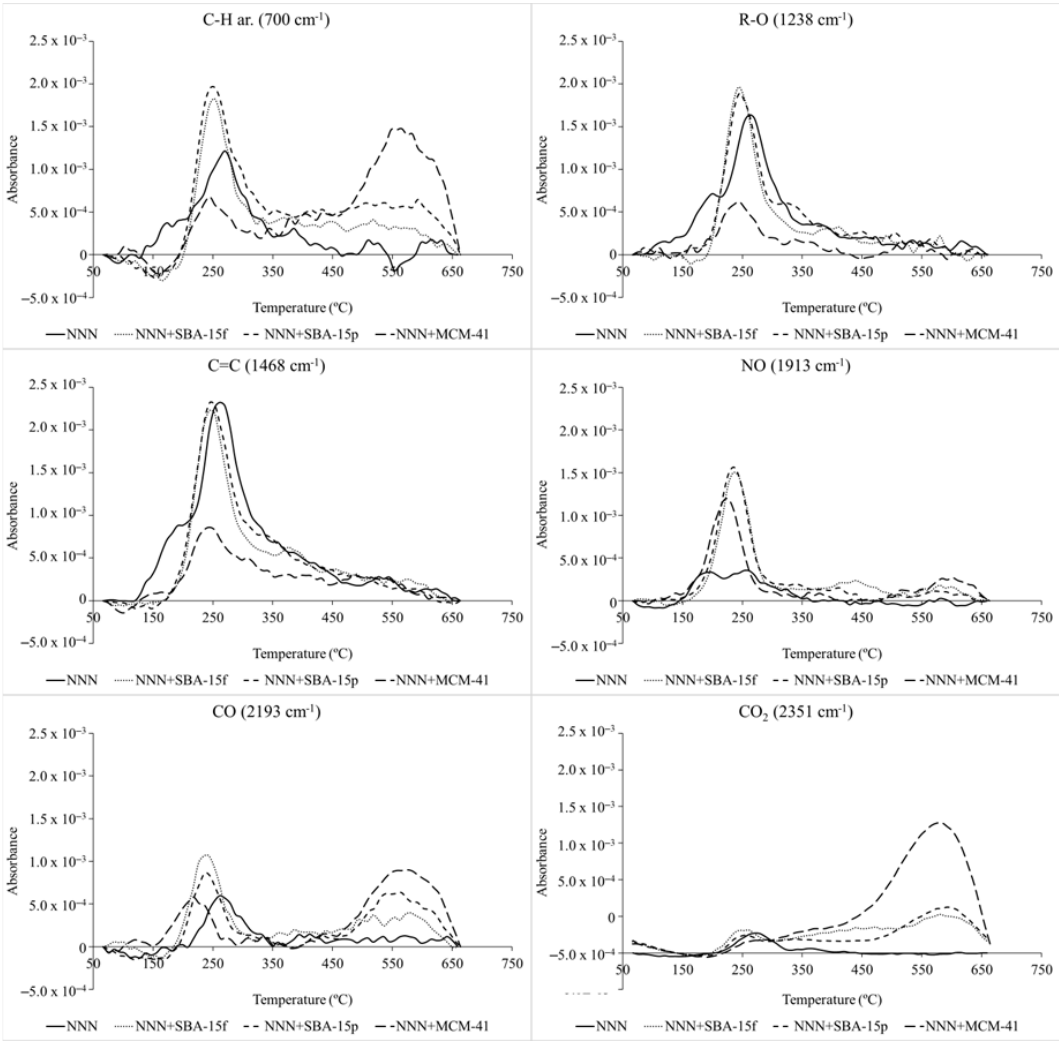
Figure 5. IR spectra of NNN and NNN with three catalysts, under oxidizing atmosphere.